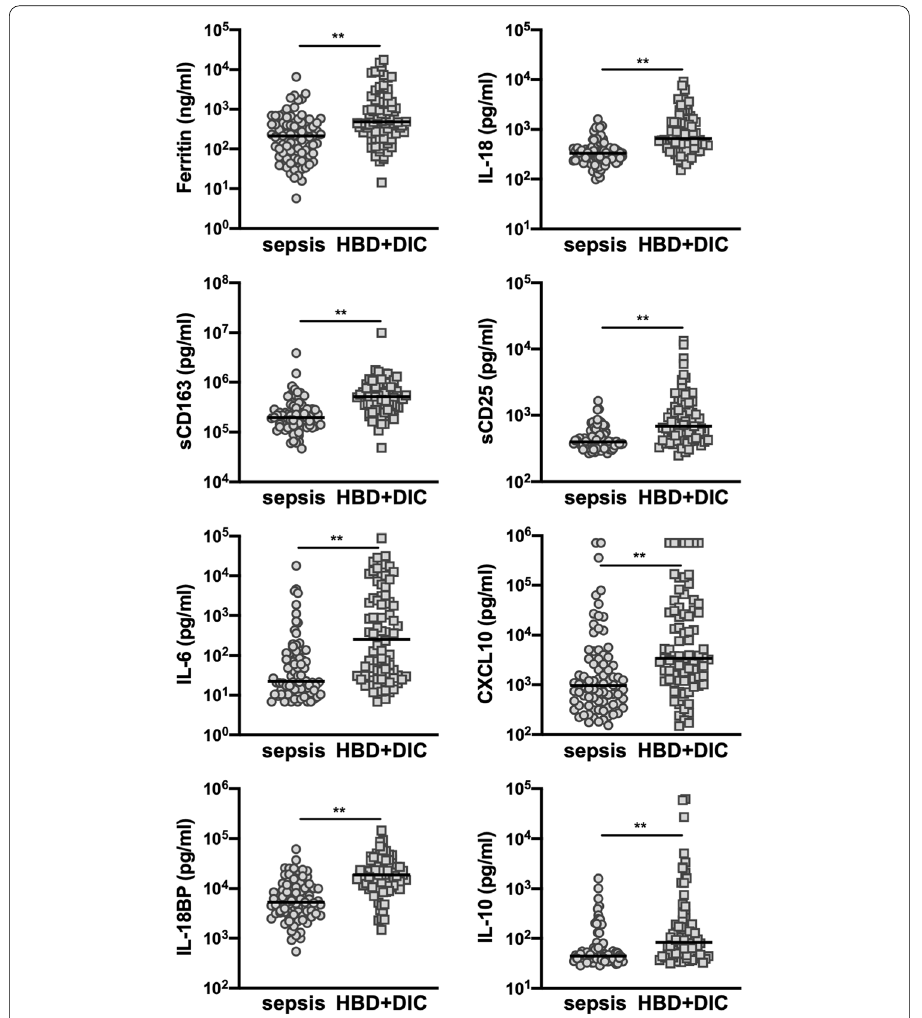
Fig. 2 Head-to-head comparison of 8 of the 26 biomarkers between sepsis controls and sepsis with HBD DIC. The comparison was achieved using the Mann–Whitney U test. ** p < 0.01 after correction for + multiple comparisons using the Holm-Šídák